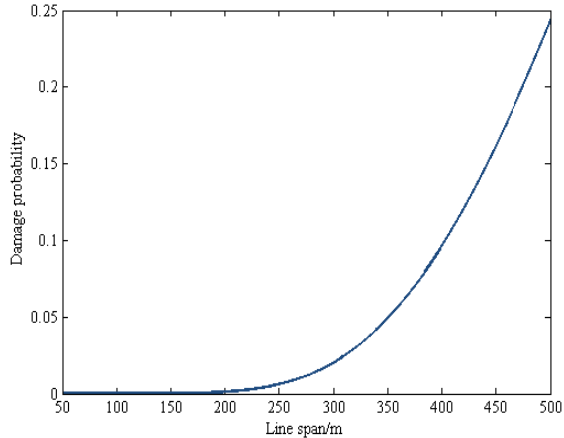
Figure 4. Relationship curve between line span and damage probability. 316